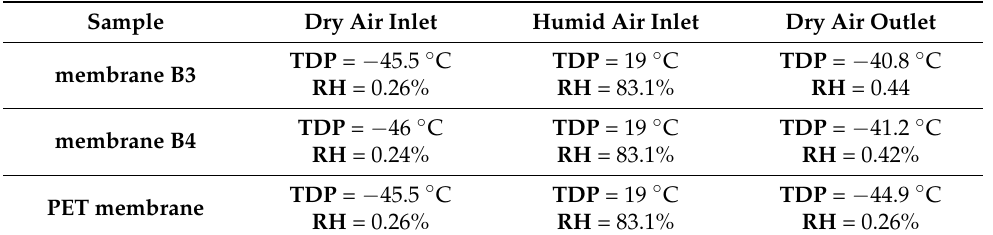
Table 1. The value of humidity at the inputs and outputs from the measurement system.